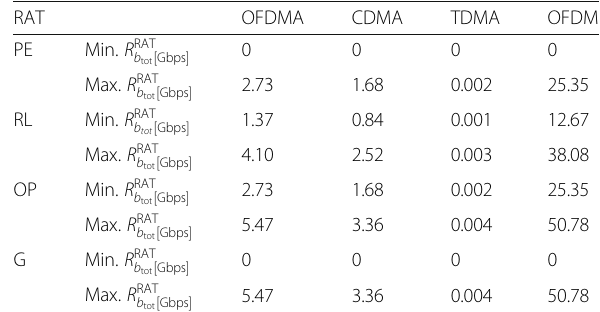
Table 3 Minimum and maximum data rate of each RAT in different approaches